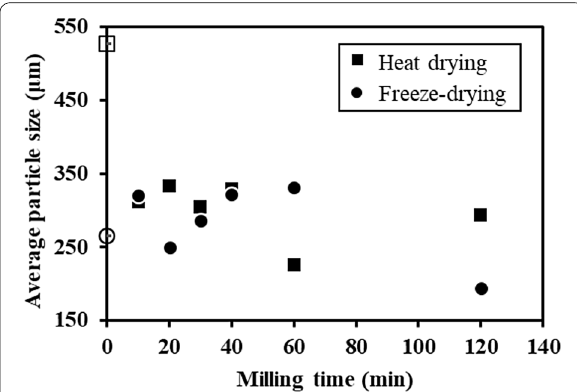
Fig. 5 The relationship between average particle size and milling time. Open square, heat drying 0 min and open circle, freeze-drying 0 min